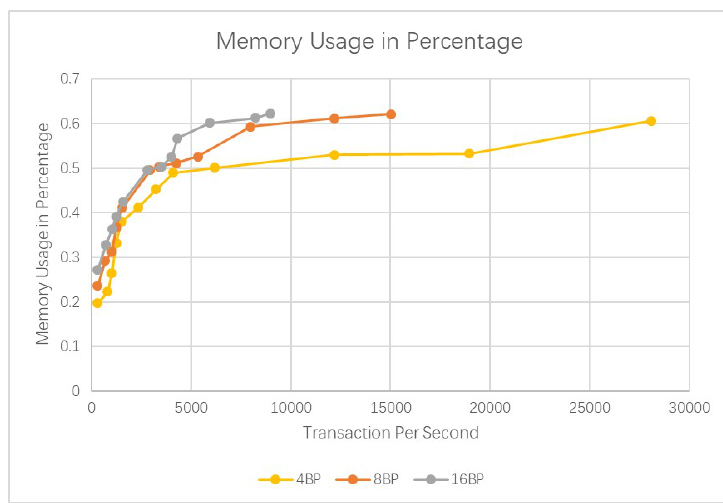
Figure 10. Comparison of the memory usage in